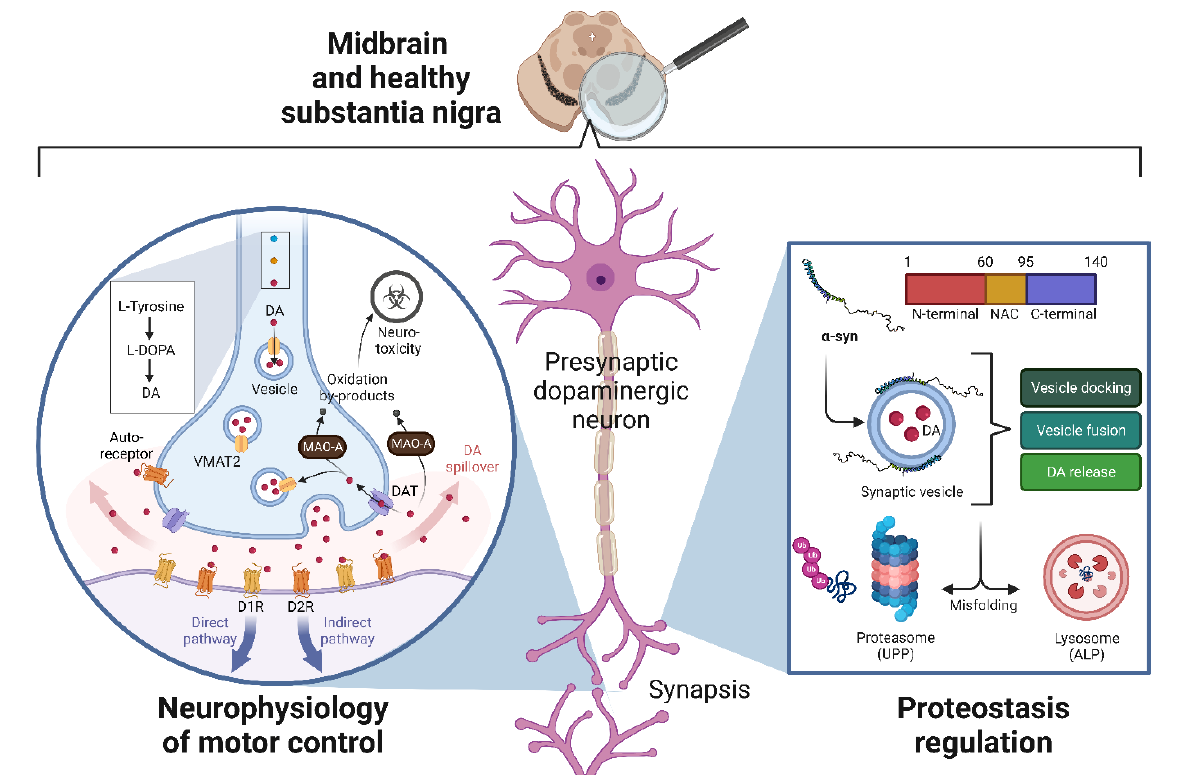
Figure 1. Neurophysiology of motor control ( left ) and proteostasis regulation ( right ) in healthy midbrain substantia nigra pars compacta dopaminergic neurons. In regular motor control, DA (synthesized from L-tyrosine) is encapsulated in synaptic vesicles by VMAT2. and then released to excite DA receptors D1R and D2R, thereby triggering the direct and indirect pathways of motor regulation, respectively. DA can spillover if not reuptaken by the neuron through the DAT. Free DA in the cytosol and the extracellular matrix can be oxidized by MAO-A into neurotoxic by-products. On the other hand, α -syn regulates the docking, fusion, and release of DA from synaptic vesicles are regulated. When the protein is misfolded, dopaminergic neurons eliminate it through the UPP or the ALP pathways. DA: dopamine; L-DOPA: levodopa; VMAT2: vesicular